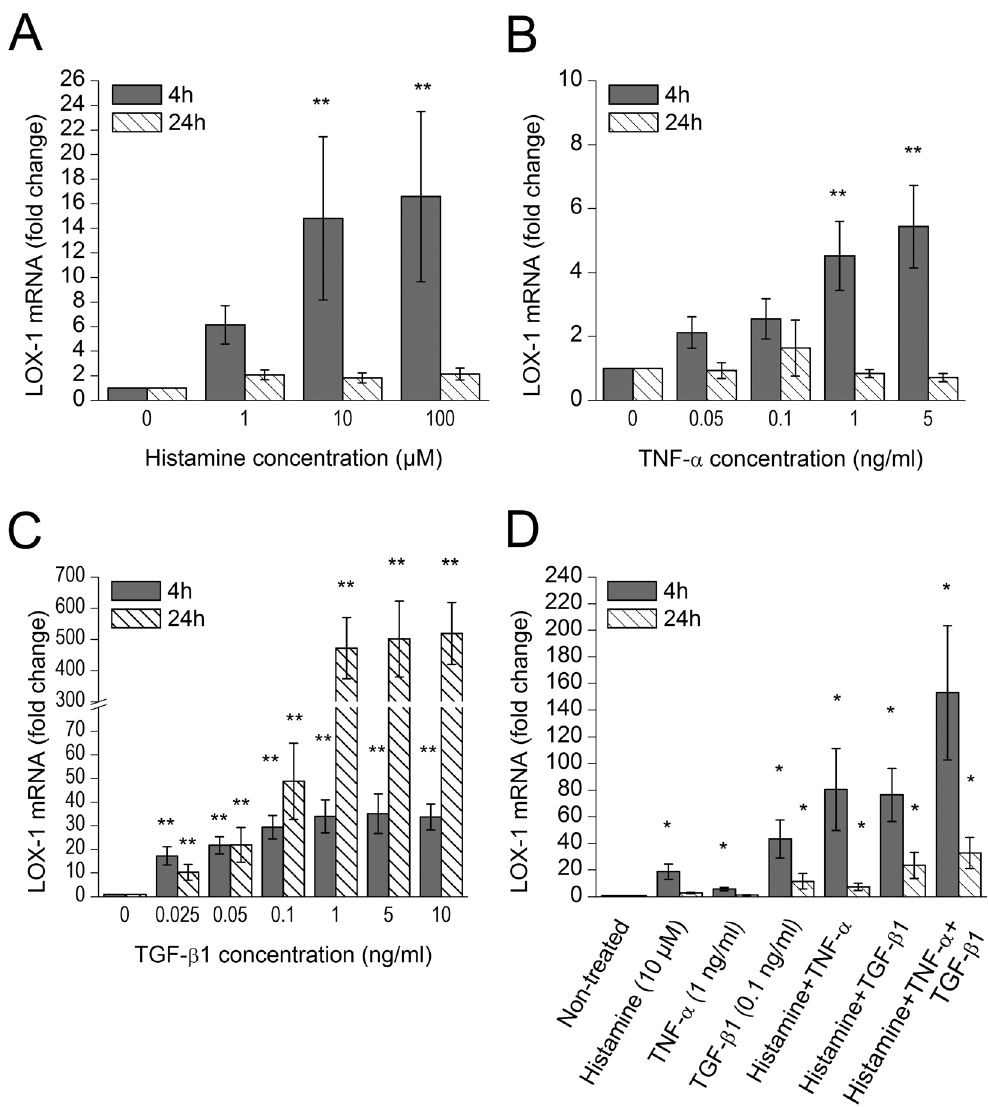
Figure 2. Effect of individual mast cell releasate components on macrophage LOX-1 expression. Monocyte-derived macrophages were incubated with A) histamine, B) TNF- a , and C) TGF- b 1 for 4 h and 24 h, and analyzed for LOX-1 mRNA expression (n=6 donors). D) The combined effect of the components was studied by incubating macrophages with histamine (10 m M) and/or TNF- a (1 ng/ml) and/or TGF- b 1 (0.1 ng/ml) for 4 h and 24 h (n=4 donors). The results are presented as means 6 SEM. *p , 0.05, **p , 0.01 vs. non-treated cells.